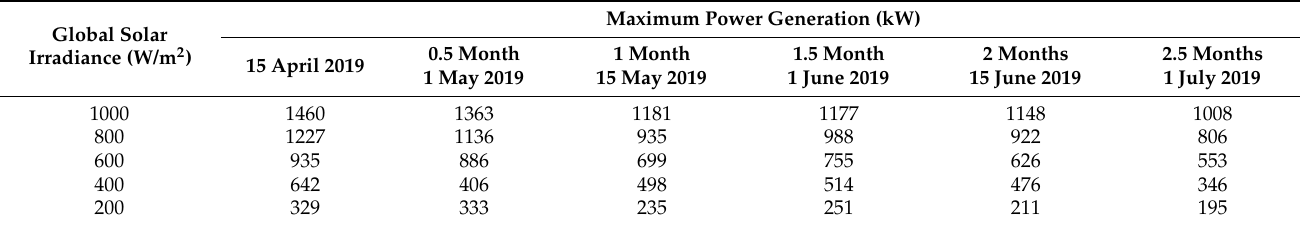
Table 6. Power generation under different solar irradiance with bi-weekly